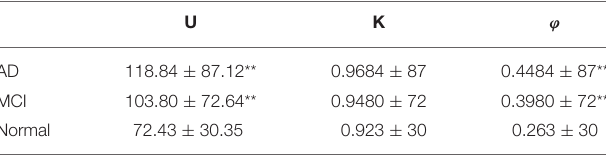
TABLE 3 | Estimation of disruption parameters U , K , and ϕ .